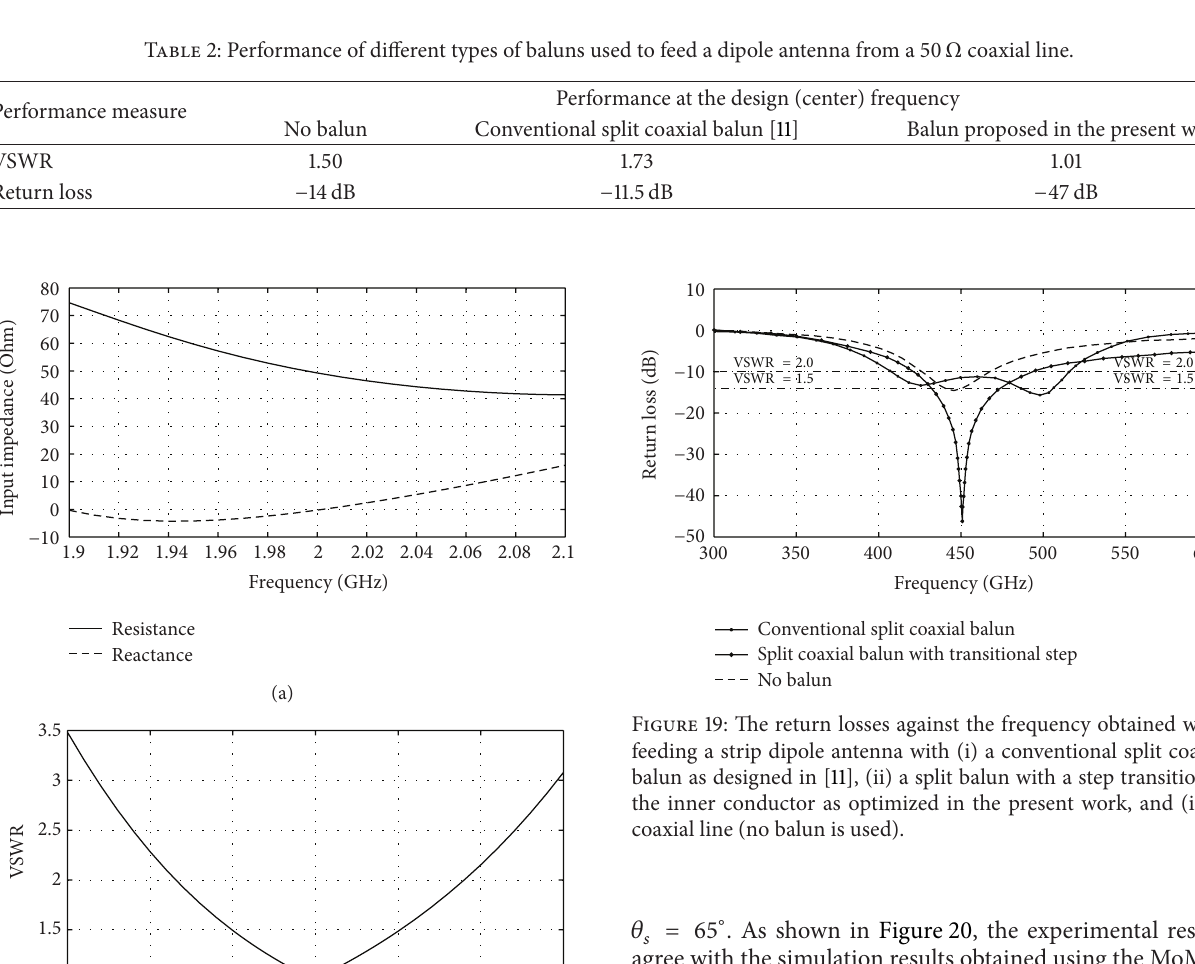
Table 1: Impedance matching bandwidth for different types of baluns used to feed a dipole antenna from a 50 Ω coaxial line. VSWR (return loss)